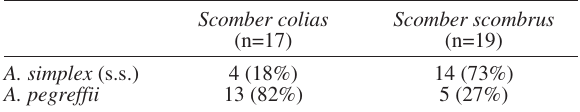
Table 2. – Anisakis species distribution in Scomber colias and S. scombrus off the Portuguese continental coast, recorded around the fish